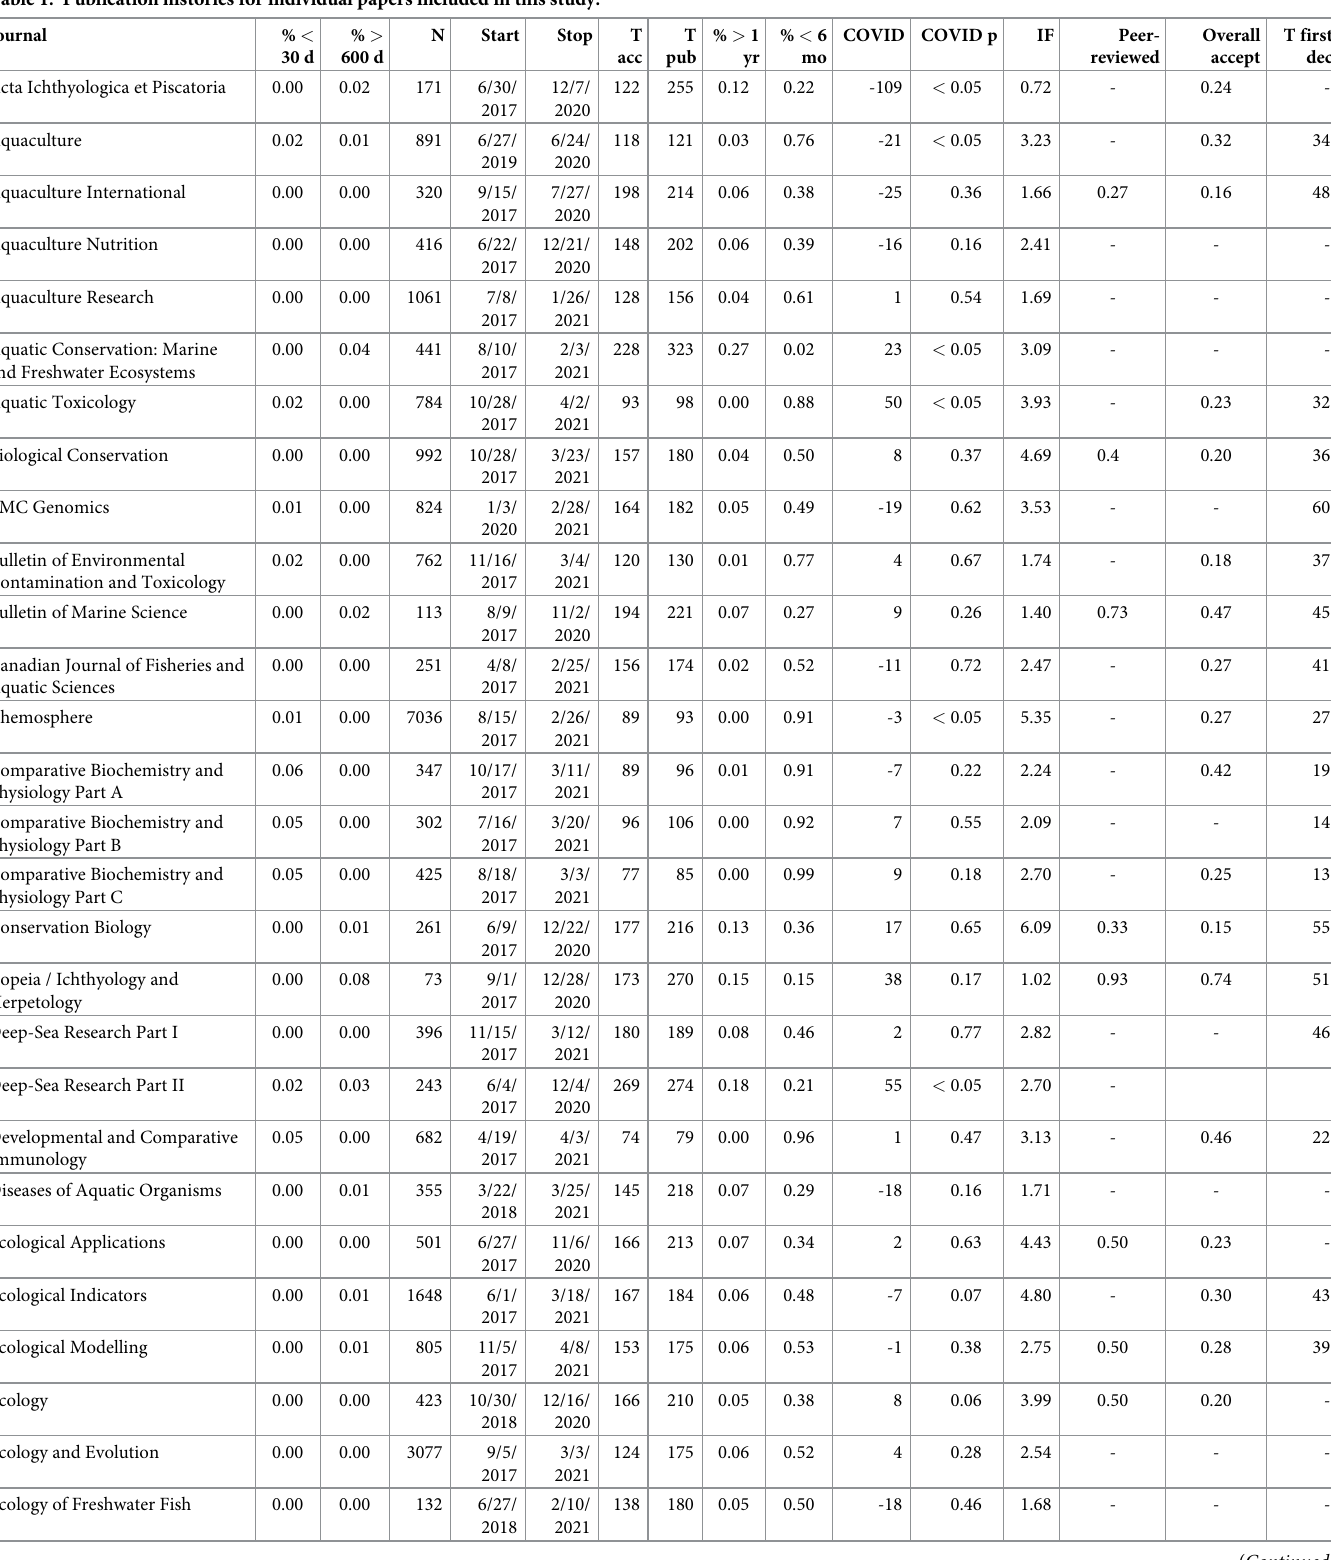
Table 1. Publication histories for individual papers included in this